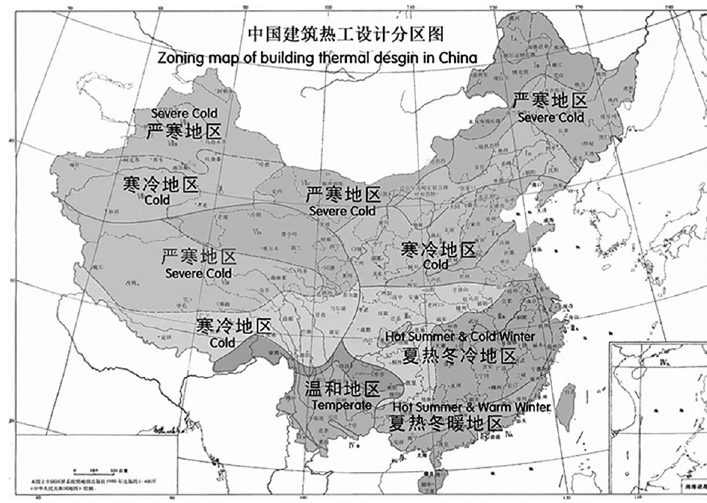
Figure 2. Zoning map of building thermal design in China (source: Thermal Design Code for Civil Building)